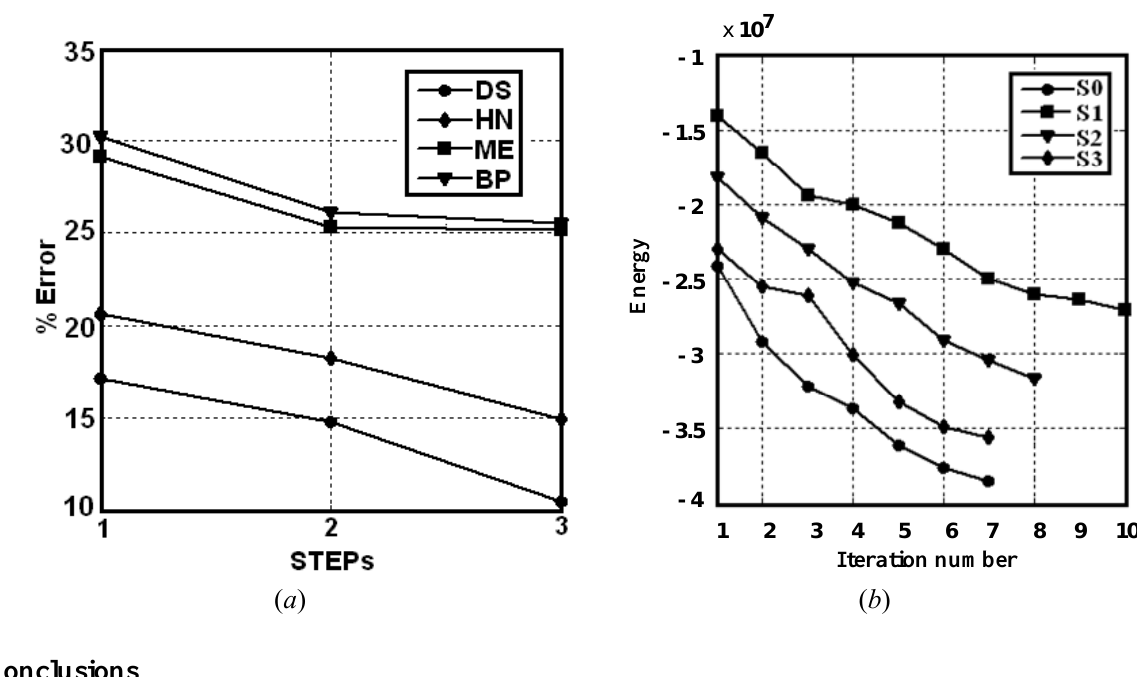
Figure 4. ( a ) percentage of error for DS, HN, ME and BP against the three STEPs; ( b ) energy behaviour for S0 to S3 against the number of